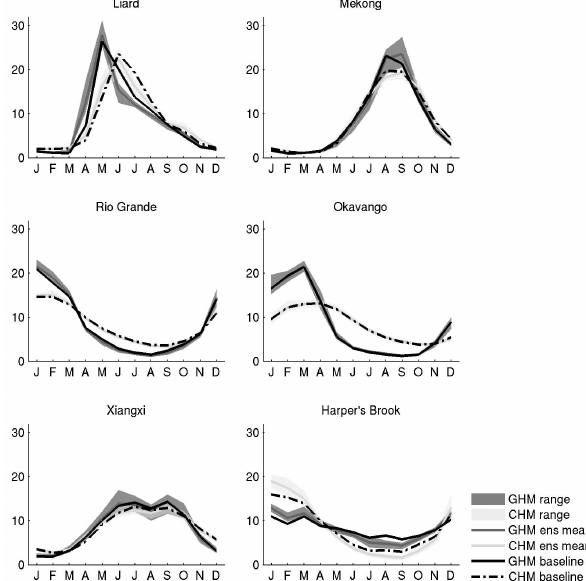
Fig. 10. Percentage change from baseline in Q5 and Q95 monthly runoff (vertical axis) for the 7GCMs (horizontal axis) under 2 ◦ C prescribed warming, as simulated by the GHM and CHM respec- tively, for each